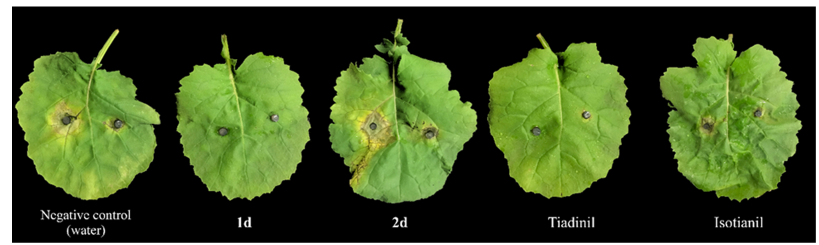
Table 4. In vivo efficacy of compounds on rape leaves infected by A. brassicicola .